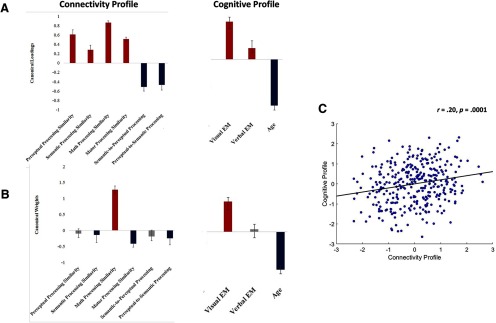
The median canonical loadings (A) and the median canonical weights (B) of the brain and behavioral variables on their corresponding canonical variate across all discovery CCAs, as well as the scatter plot describing the linear association between the two canonical variates across all the test folds (C). In panels A, B, error bars reflect the smallest and largest value, respectively, corresponding to the loading (A) or canonical weight (B) of each variable on its corresponding variate across all the discovery CCAs. The scatter plot in panel C is based on standardized variables.